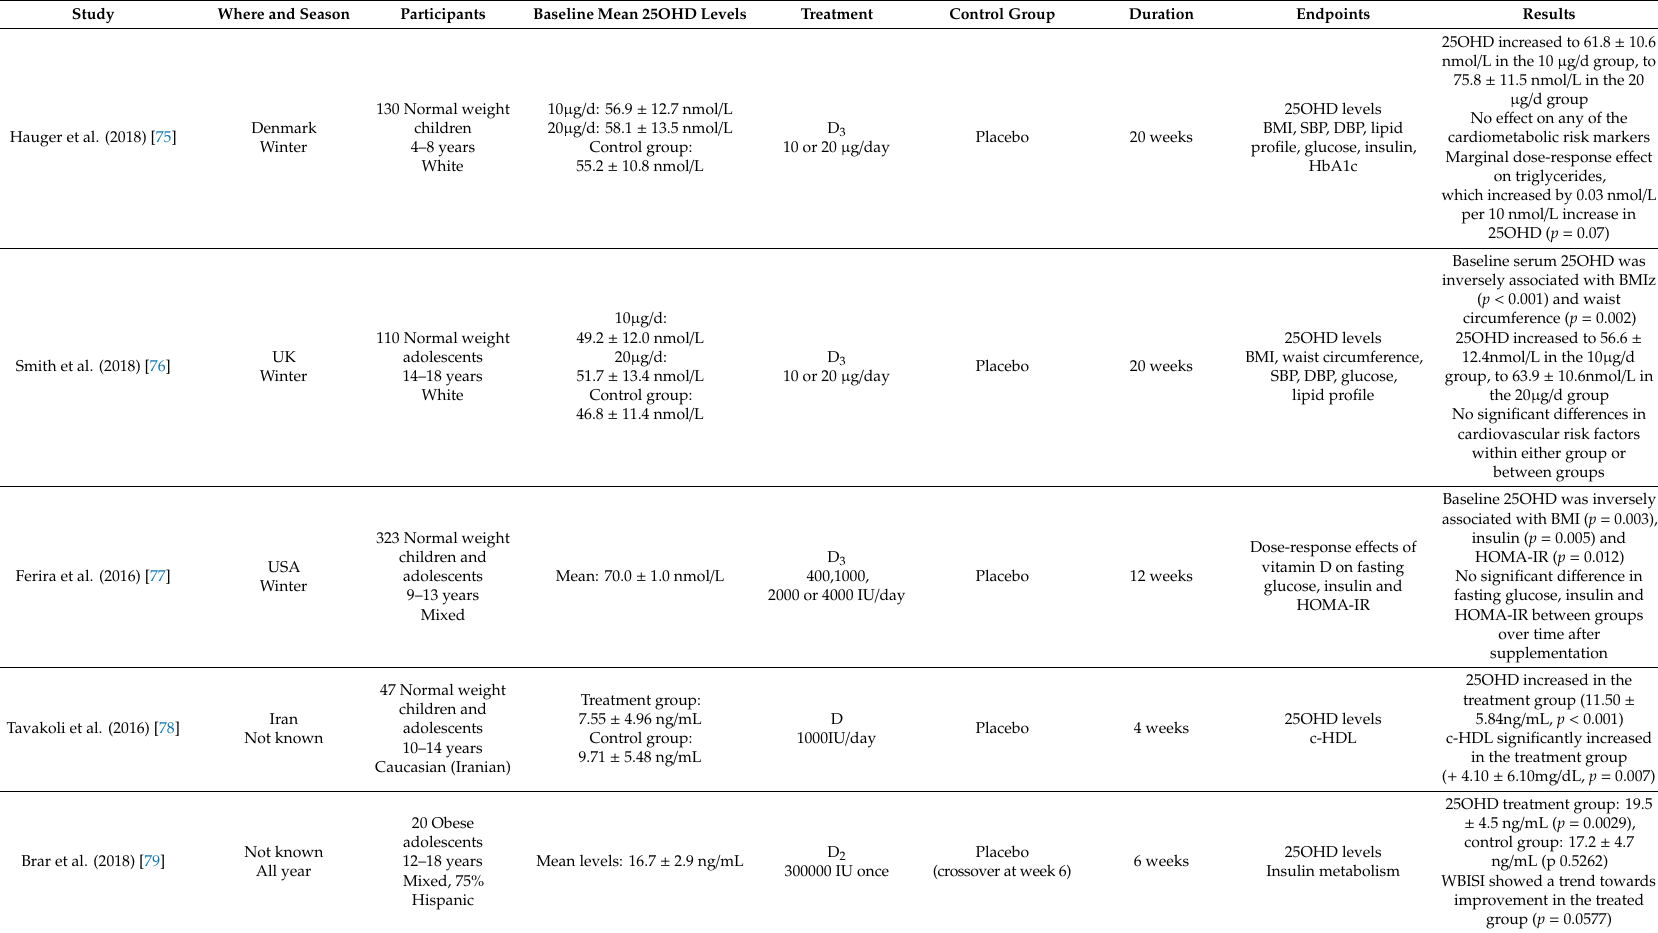
Table 2. Reviewed studies on vitamin D supplementation and cardiovascular risk factors in pediatric age. WBISI: Whole Body Insulin Sensitivity Index; HbA1c: Glycated haemoglobin; hs-CRP: high-sensitivity C-Reactive